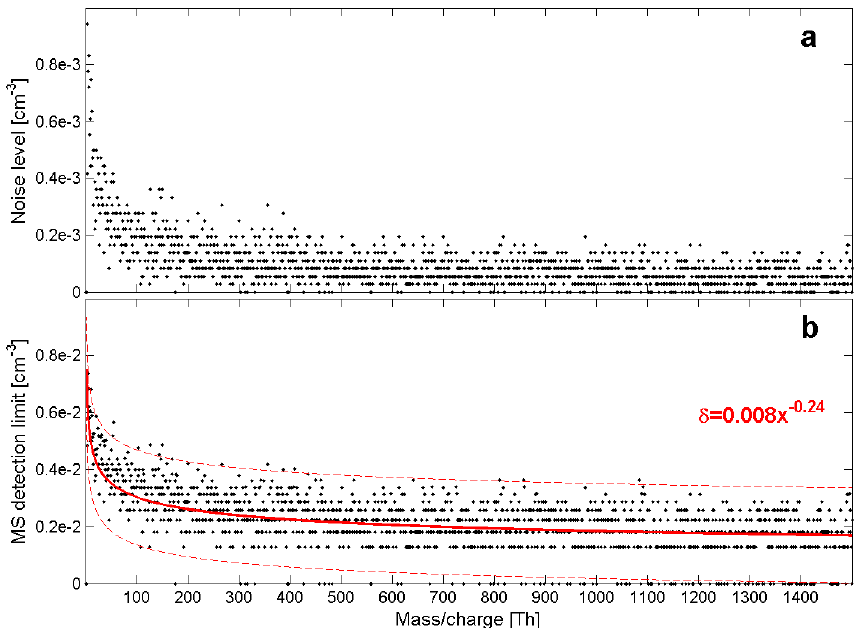
Fig. 2. The background noise and mass spectrometer detection limit of the APi-TOF based on a 60min average of ambient sampling with an ion filter in front of the inlet. In panel (a) , the black dots are 60 min average integrated signals at 1Th resolution.In panel (b) , the black dots are 3 times the standard deviation of the integrated signal, the red solid line is a power law fit to the data, and the red dashed lines are 95% confidence interval levels of the fit.